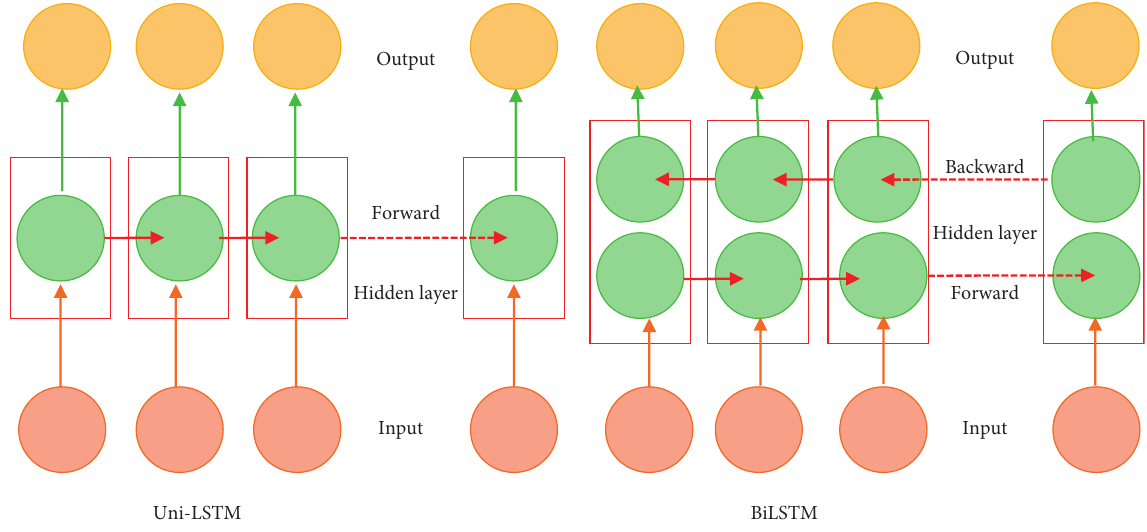
Figure 7: Uni-LSTM/BiLSTM architecture.